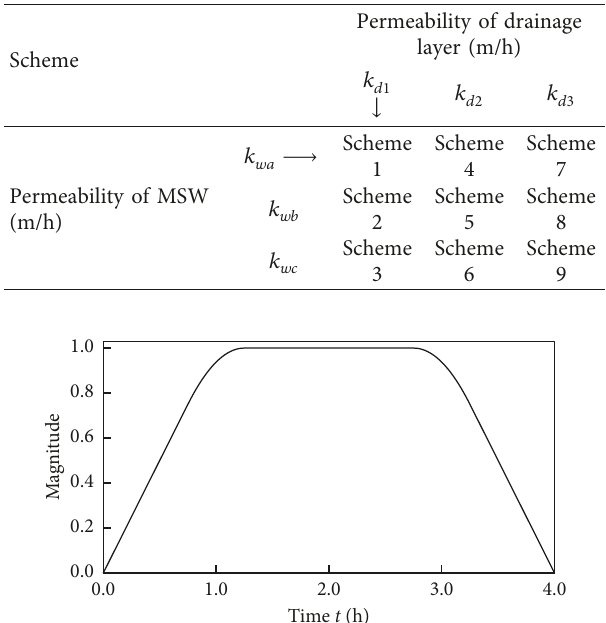
Figure 10: Permeability of MSW distributed logarithmically and indexed in the spatial and temporal domains, respectively (m/h). Table 2: Calculation schemes.